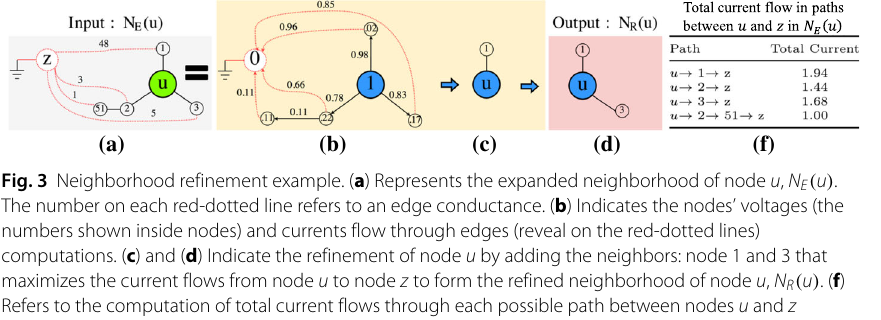
in (f). The paths are then added in descending order of total current into N R ( u ) until